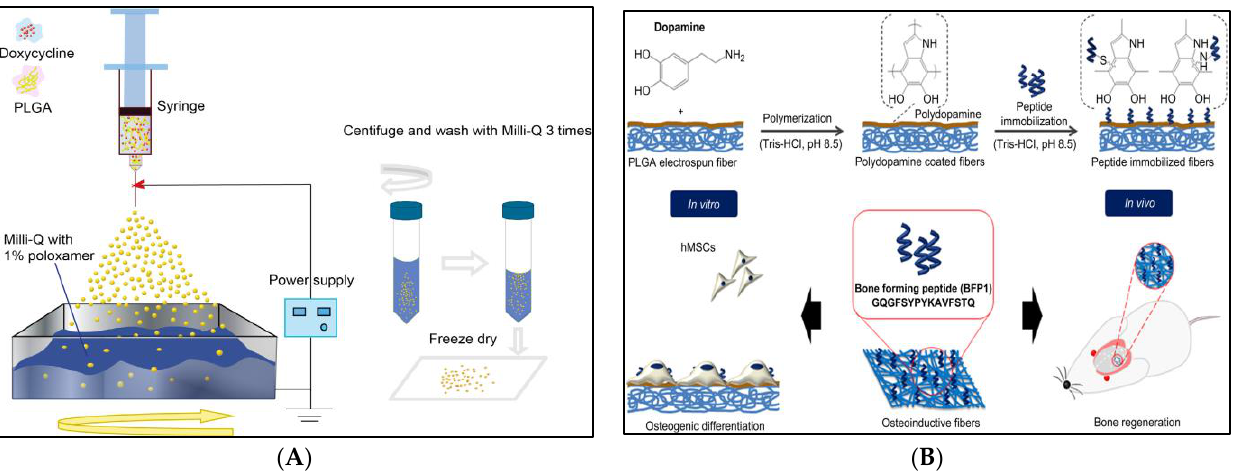
Figure 6. The figure represents different applications of PLGA. ( A ) Schematic diagram of the fabrication of drug-loaded PLGA microspheres by electrospraying. ( B ) Schematic illustration of the preparation of Dopamine with immobilized BFP1 by polydopamine coating. Figure ( A ) is reproduced from [33] and Figure ( B ) from [94] with copyright permission.